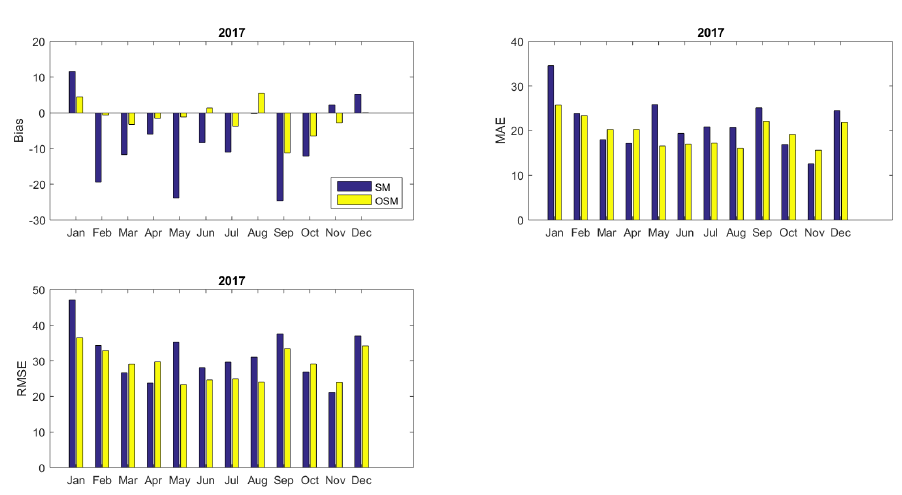
Figure 8. Statistical error indices for the energy prediction through the simulation model (SM) and the optimized simulation model (OSM) for the year 2017 (per month).